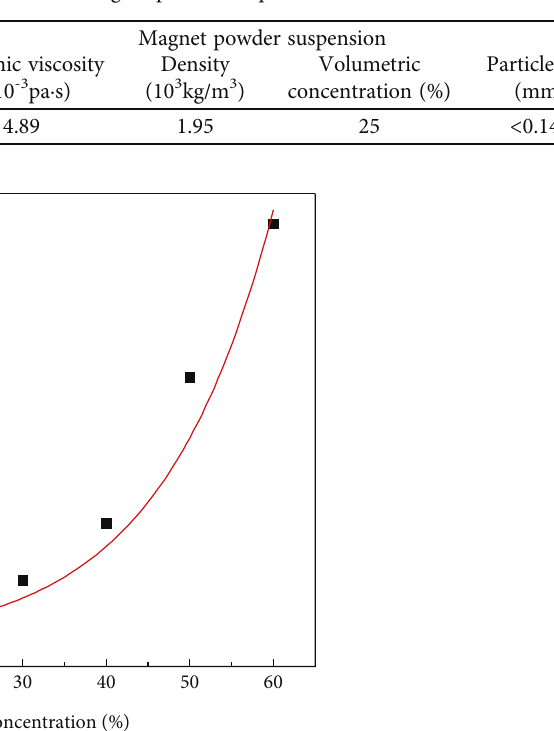
Table 1: Basic parameters of magnet powder and magnet powder suspension.